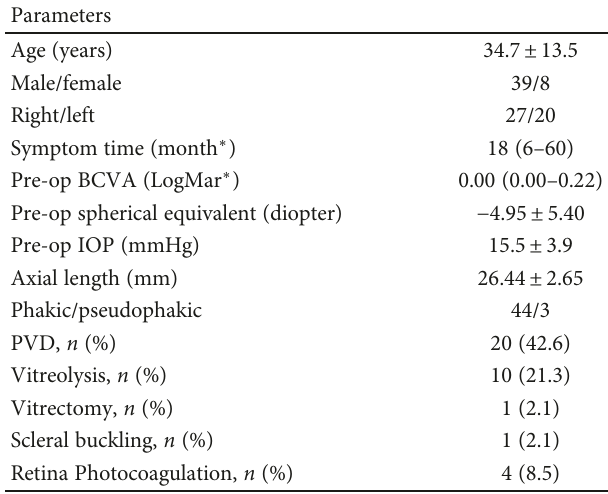
Table 1: Baseline demographics and characteristics of patients.